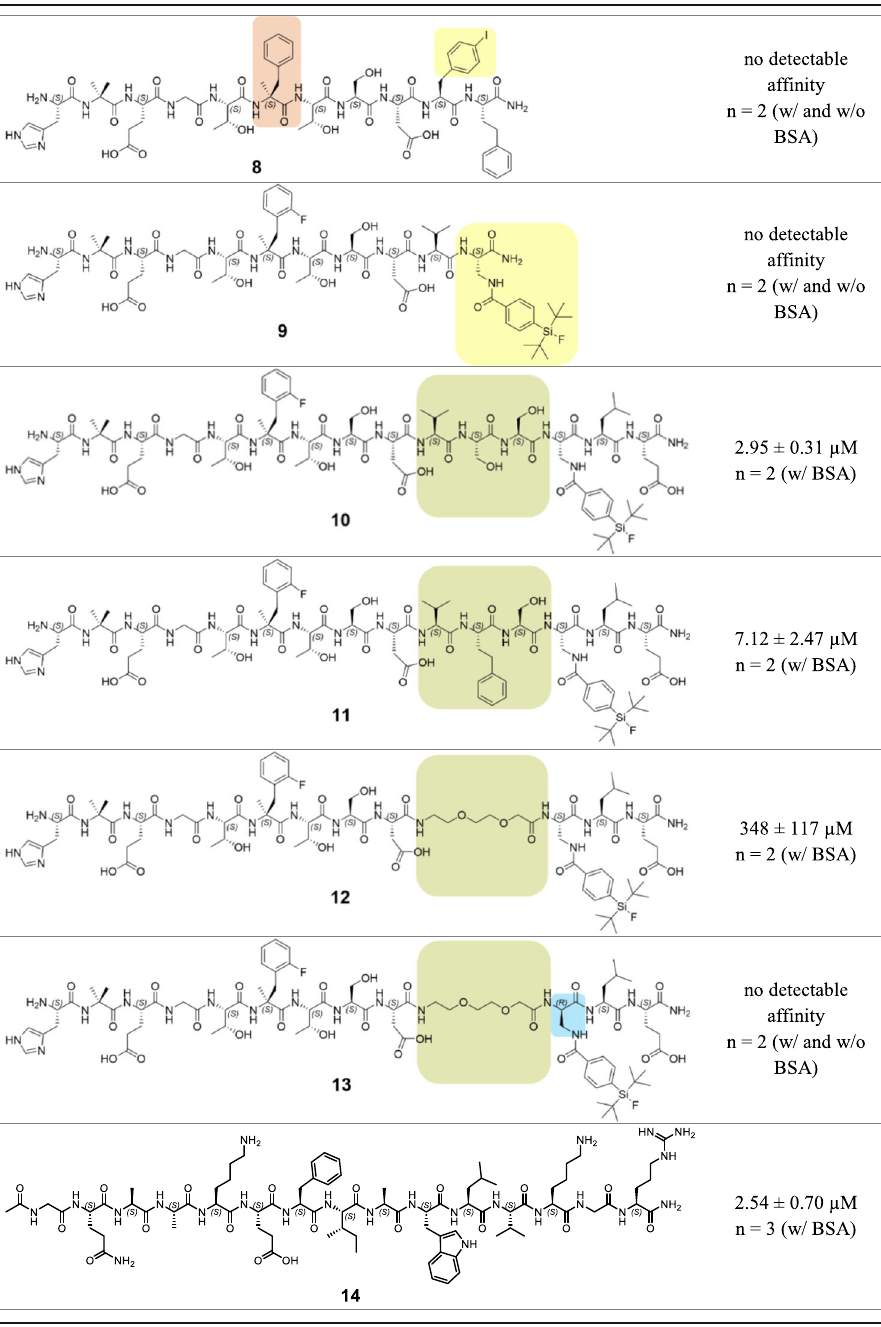
Table 1 IC 50 data of SiFA-tagged undecapeptides ( 4 and 5 ), peptides without C-terminal bulky substituents ( 6 , 7 and 8 ), SiFA-tagged chimeras of 1 and GLP-1 ( 9 to 13 ) as well as the C -terminal pentadecapeptide of GLP-1 ( 14 ) developed for targeting the GLP-1 receptor. IC 50 values